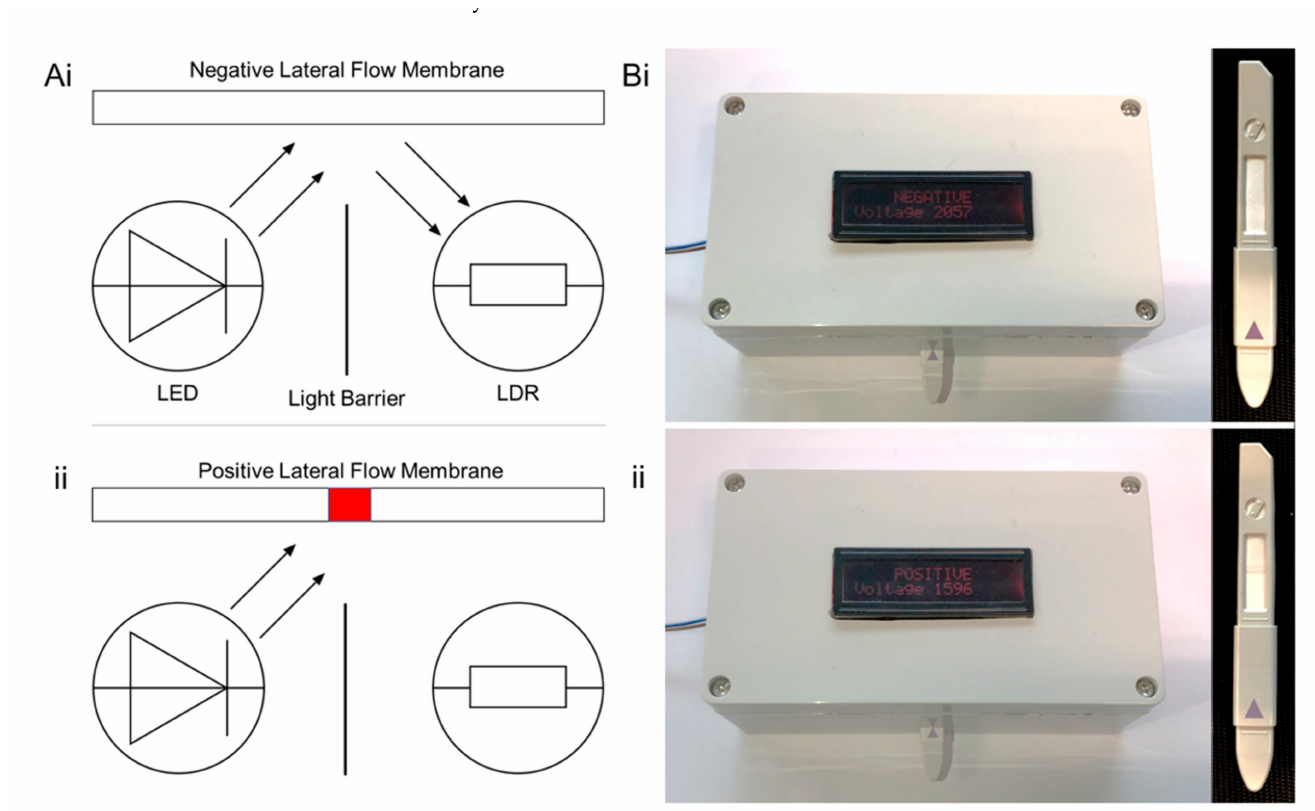
Figure 4. ( A ) Diagrammatic representation and ( B ) photographs of desktop detector response to (Ai,Bi) negative and (Aii,Bii) positive conserved target enteroviral nucleic acid sequence lateral flow assay. For further information see Figure S3 and Supporting Movie S2 (Supplementary